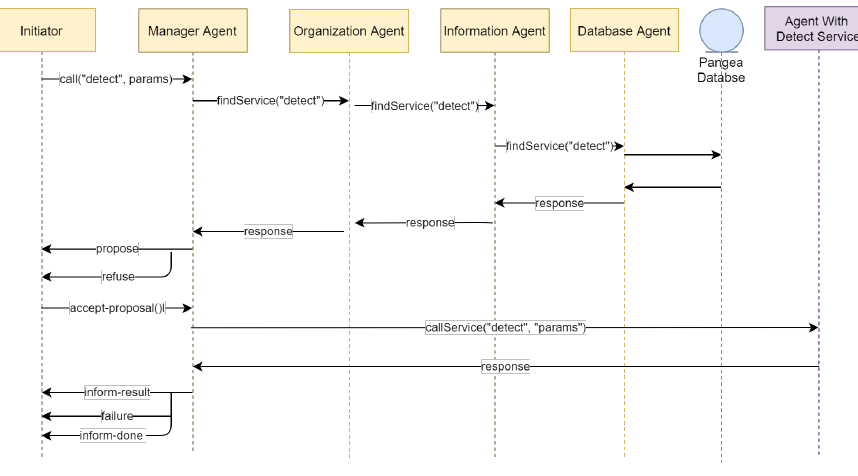
Figure 2. Image call